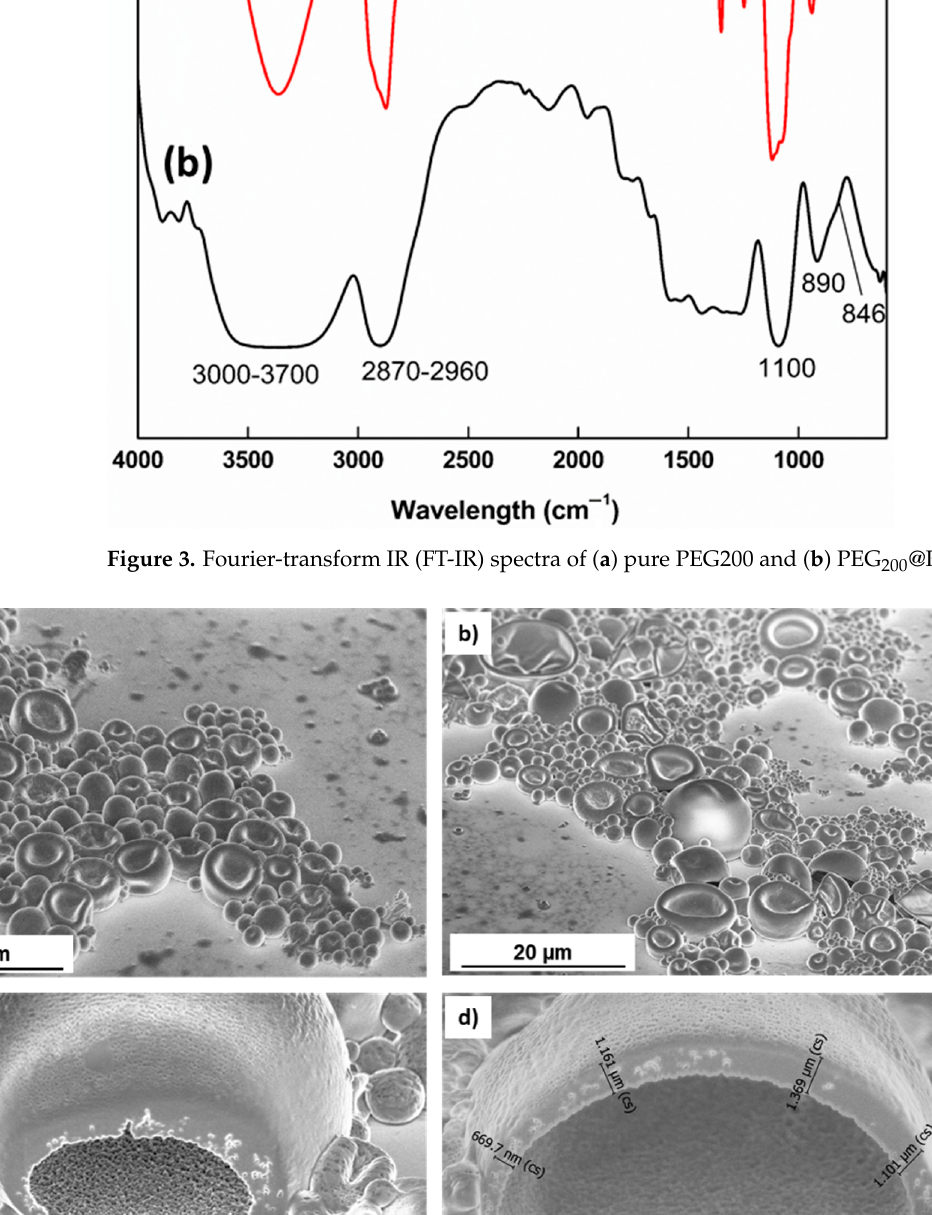
Figure 4. Focused ion beam (FIB)-SEM images of the Pd NPs /PEG 200 @PU MCs ( a – d ).